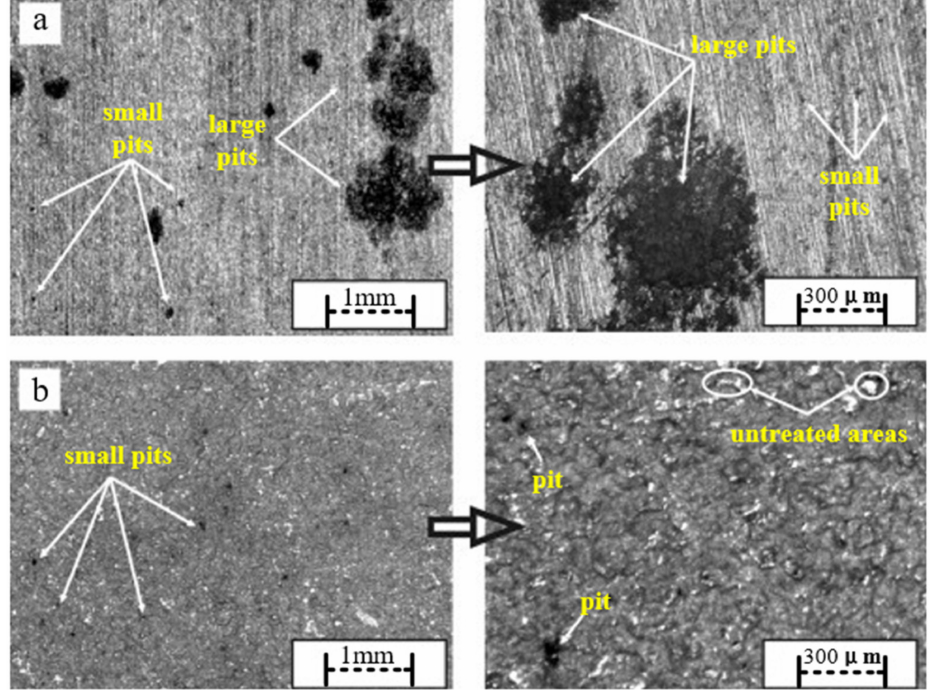
Figure 11. Changes of pits on the corroded surfaces of AA6082-T651 aluminum alloy. ( a ) Without laser shot peening; ( b ) with laser shot peening